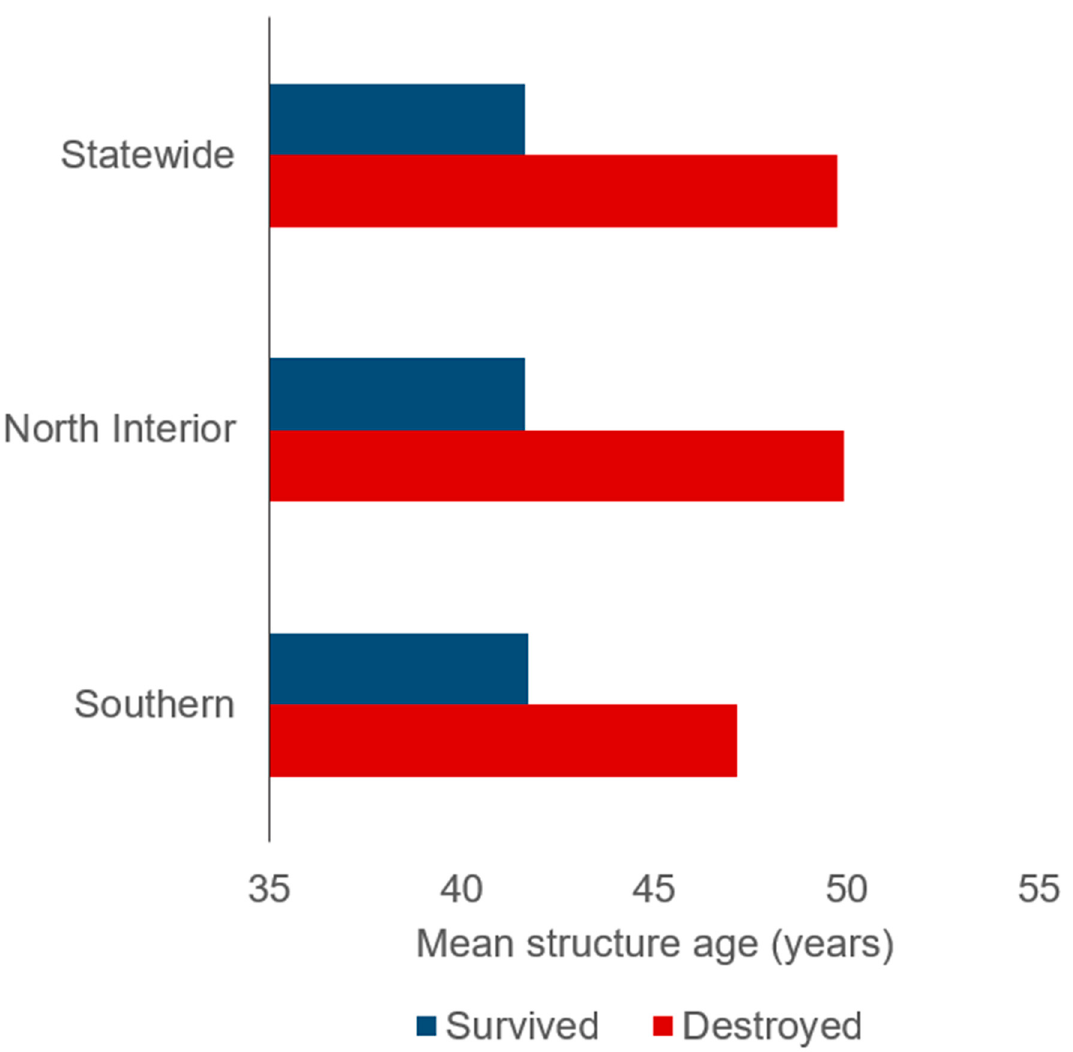
Figure 3. Mean age of structure for survived and destroyed homes in two California regions. The statewide calculations are based on combined totals of both regions (i.e., the Bay Area did not include this variable).